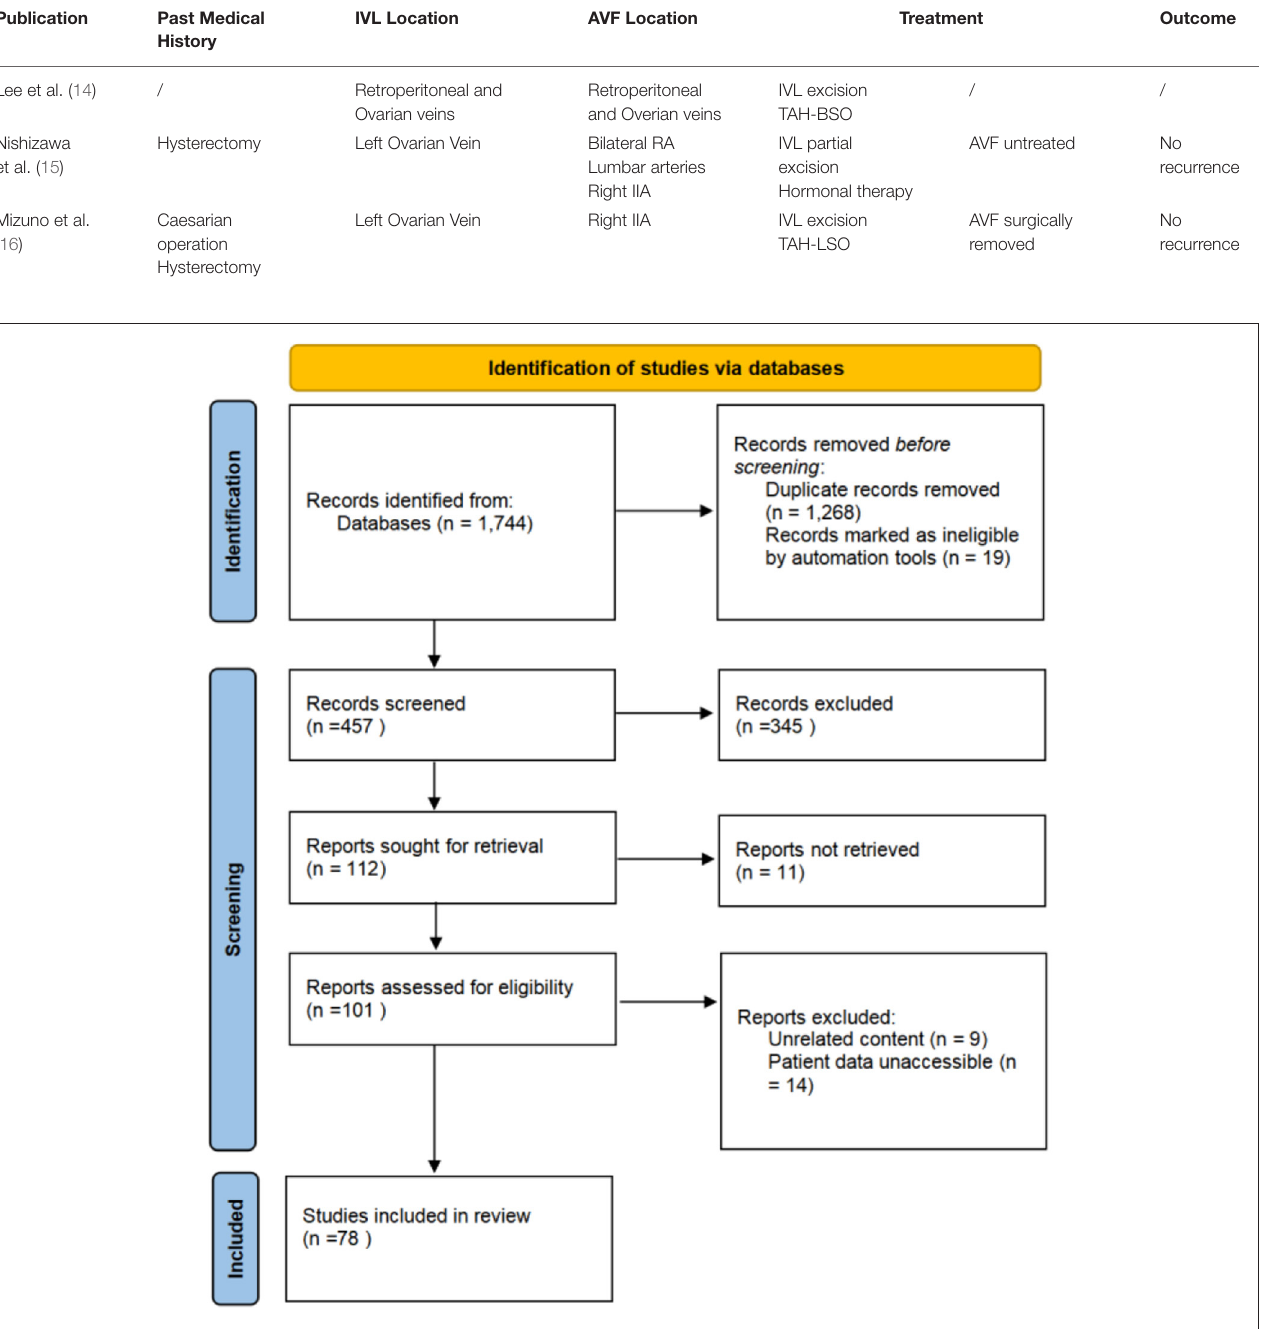
FIGURE 5 | The Preferred Reporting Items for Systematic Reviews and Meta-Analyses (PRISMA) diagram of study screening for the literature review. A total of 1,744 studies were identified, from which 78 were included in the